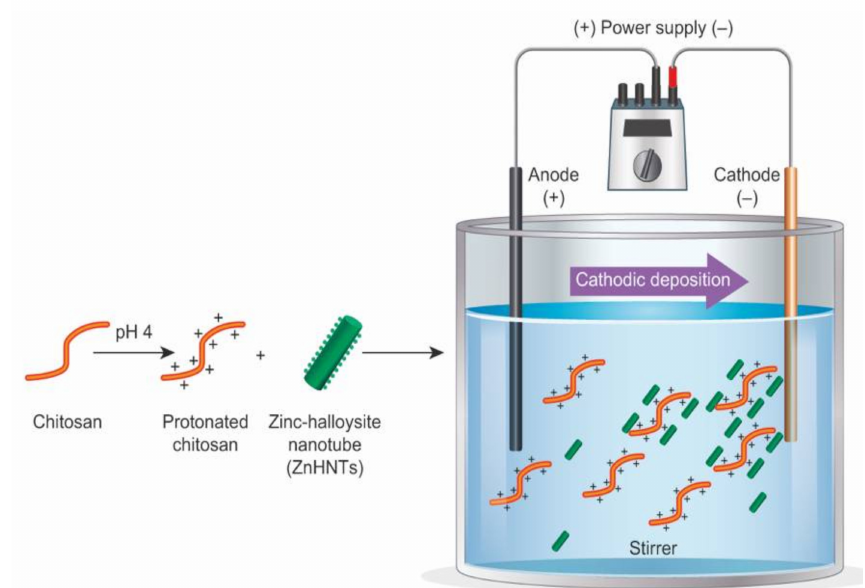
Figure 1. Graphical overview of the electrophoretic deposition process. An electrolysis setup consisting of two platinized titanium meshes held parallel at a 2-inch distance and connected to a DC power source. An ultrasonicated 100 mL aqueous solution of metal salts and HNTs were dispersed in a glass beaker and subjected to 20 V at 80 ◦ C with polarity reversal at every 5 min [18] under constant stirring. Afterwards, the supernatant was decanted thrice, and the solution was combined with water to separate the mHNTs from non-adsorbed metal particles; they were dried at 30 ◦